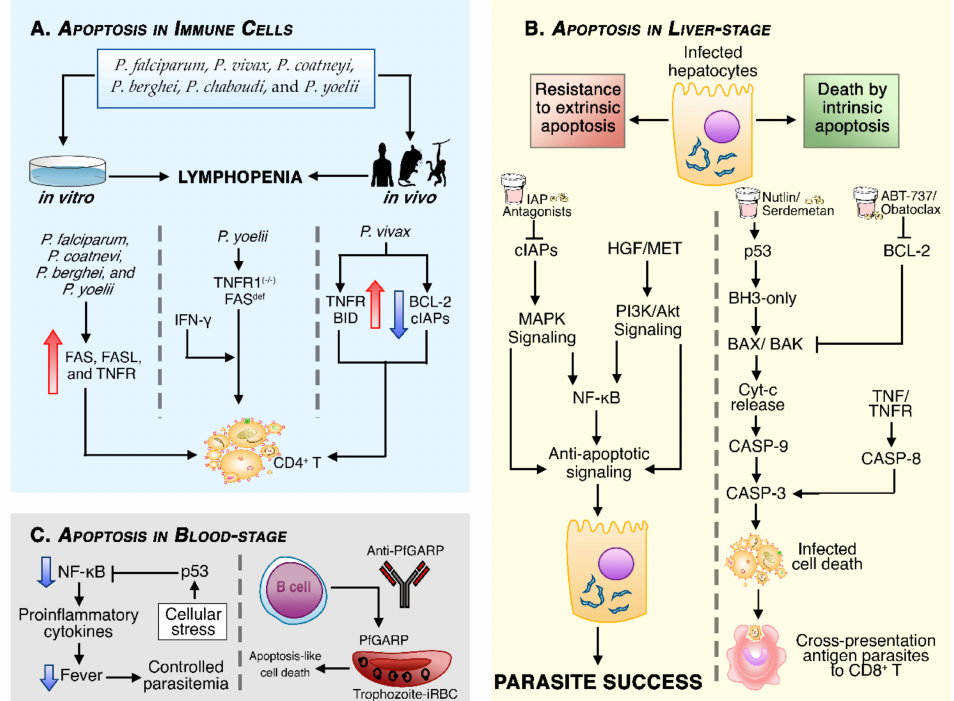
Figure 2. Schematic illustrations of different forms by which apoptosis is involved in malaria. ( A ) Several Plasmodium species were associated with extrinsic and mitochondrial apoptosis of immune system cells, but apoptosis appears to be more pronounced in T cells, leading to lymphopenia in infected humans and animals. ( B ) In the liver stage, the parasite prevents extrinsic apoptosis by activating the production of hepatocyte growth factor (HGF), which possess a strong anti-apoptotic effect in the initial phase of liver infection. In addition, the infection causes an upregulation of cIAPs by an unknown mechanism; however, infected hepatocytes are susceptible to mitochondrial apoptosis, so in the liver stage, intrinsic apoptosis plays a more prominent role in restricting the replicative niche of Plasmodium. ( C ) In the blood stage, p53 regulates apoptosis by suppressing NF- κ B activity, and the anti- P. falciparum glutamic-acid-rich protein (PfGARP) antibodies kills trophozoite-infected erythrocytes by apoptosis-like cell death, conferring resistance to P. falciparum